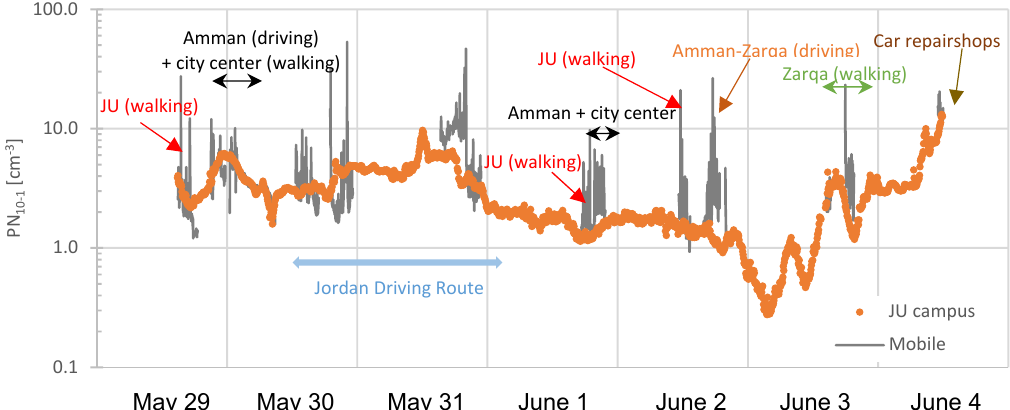
Figure 2. Super-micron particle number concentrations (PN 10–1 ) measured at the reference urban background (campus of the University of Jordan) and compared to that measured with the mobile measurement campaigns.